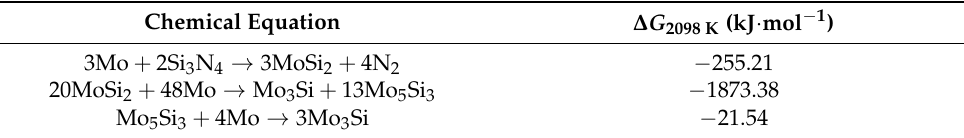
Table 4. Gibbs free energy of friction chemical reaction.